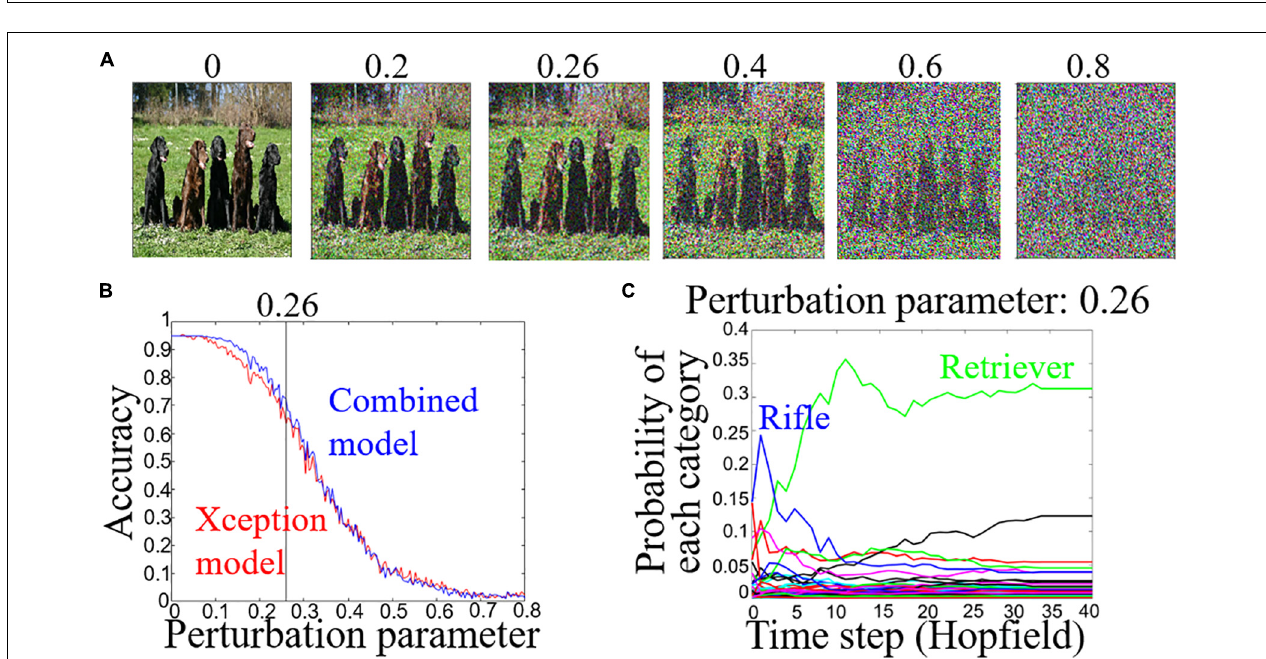
FIGURE 2 | (A) Adversarial examples for perturbation parameter. The original image is taken from the ImageNet database. (B) Accuracy in estimating correct category for perturbation parameters of the Xception model (red line) and combined model (blue line). (C) Time course for the probability of each category for Retriever image (A) at perturbation parameter